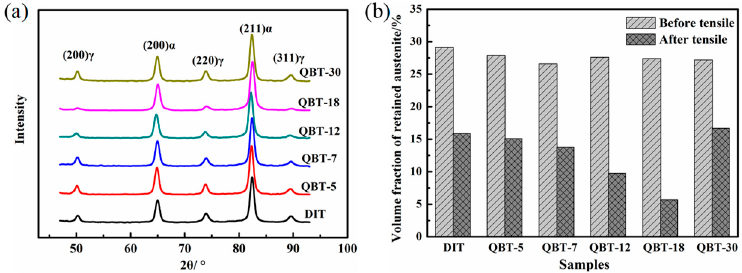
Figure 10. ( a ) XRD spectra and ( b ) volume fraction of retained austenite after tensile